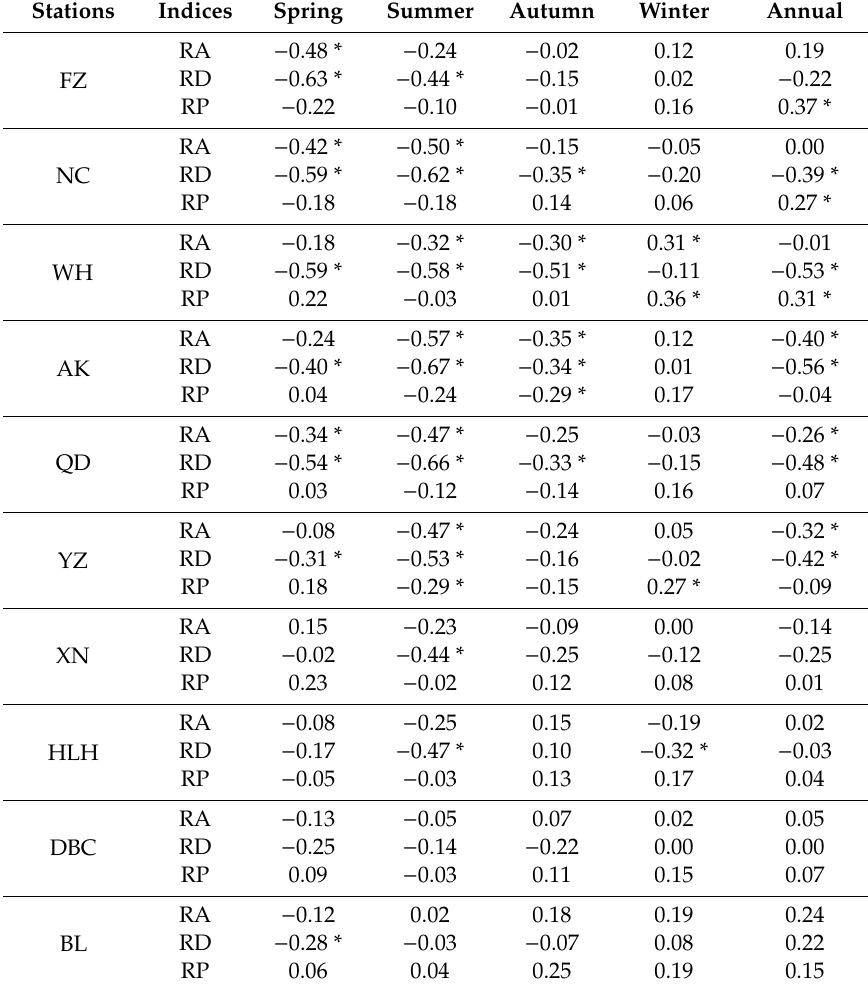
Table 4. Pearson’s correlation coe ffi cients between precipitation indices and average daily temperature at each meteorological station during